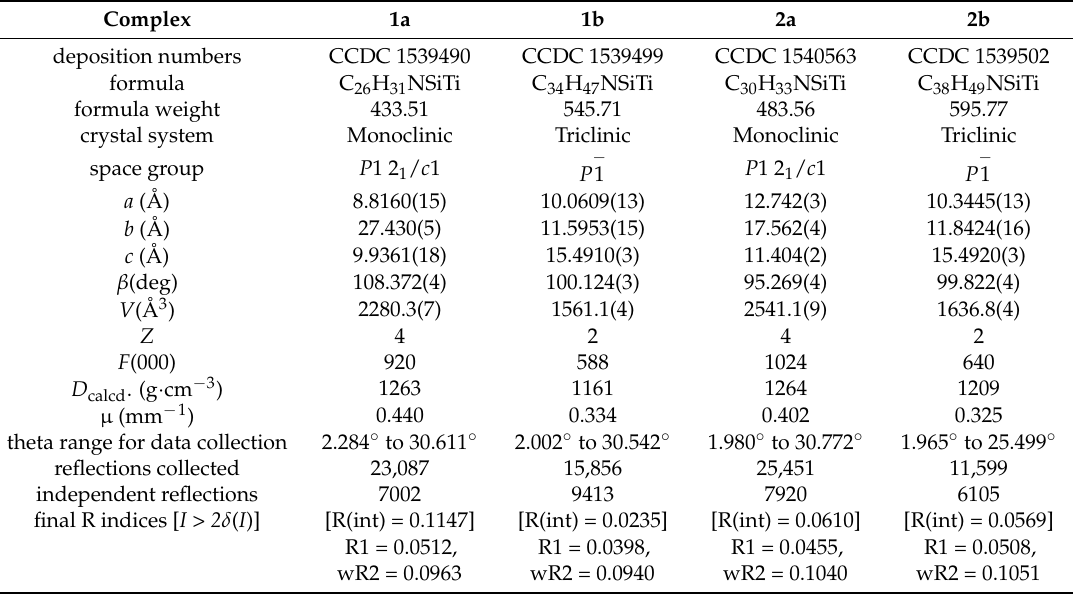
Table 1. Crystallographic data and parameters for 1a , 1b , 2a , and 2b .